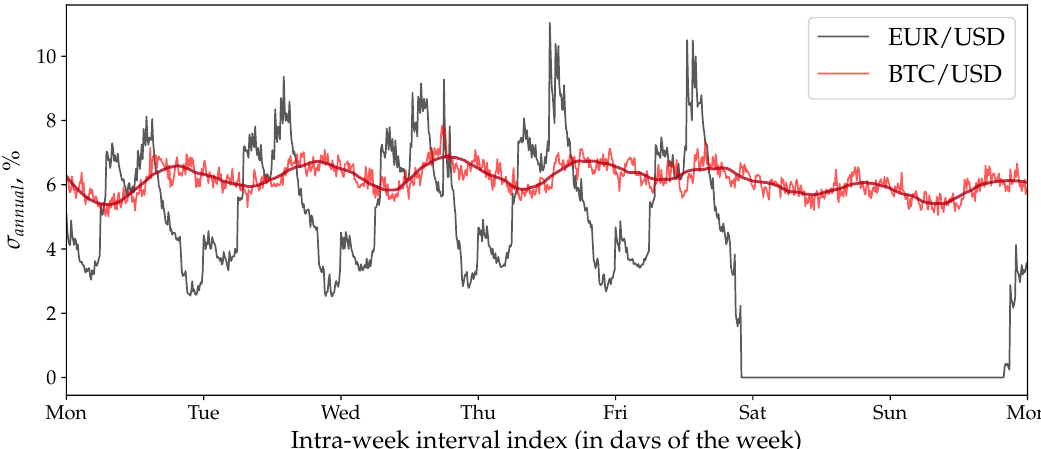
Figure 9. Instantaneous volatility seasonality of BTC/USD compared to the seasonality pattern of EUR/USD computed using the directional-change approach (Equation (19)). The dark-red curve approximates the Bitcoin seasonality pattern using the Savitzky–Golay filter (number of points in the window is 101, the order of the polynomial is 2). The directional-change threshold δ = 0.01% was used in both experiments. Each discrete time interval (bin) is T = 10 min. There are 1008 bins in total.